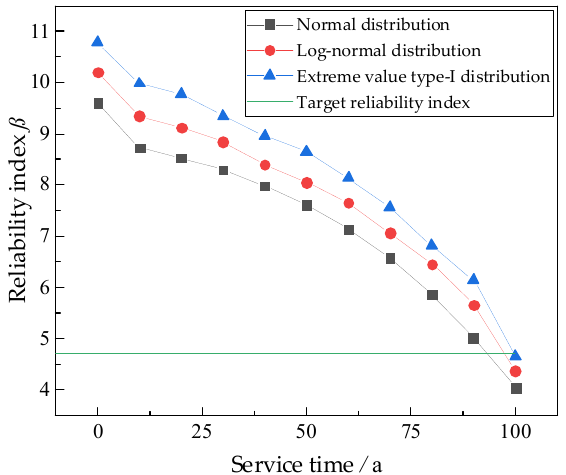
Figure 10. Influence of the parameter distribution mode on time ‐ varying